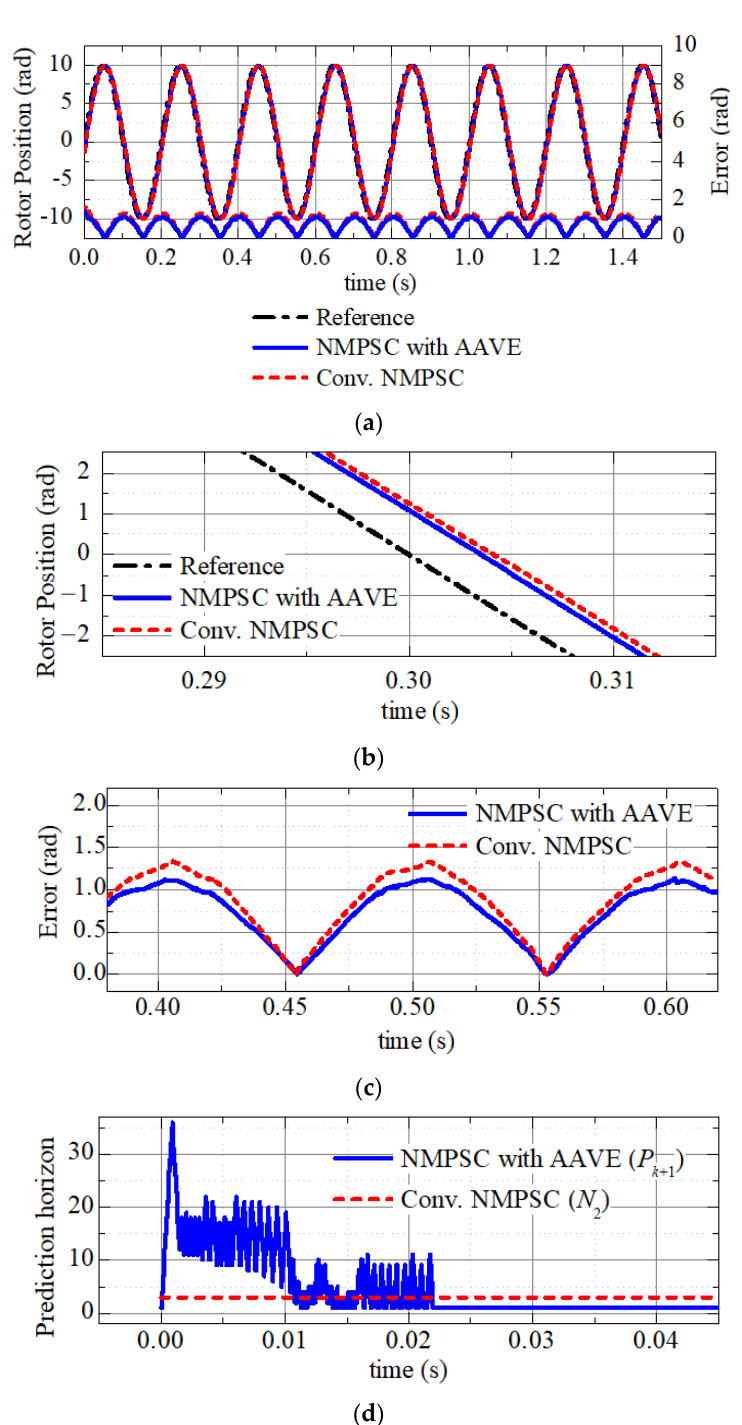
Figure 6. Rotor position, error, and prediction horizon waveforms of the proposed NMPSC with AAVE method and the conventional NMPSC. ( a ) Rotor positions and errors; ( b ) Part enlarged rotor positions; ( c ) Part enlarged errors; ( d ) Prediction horizon.